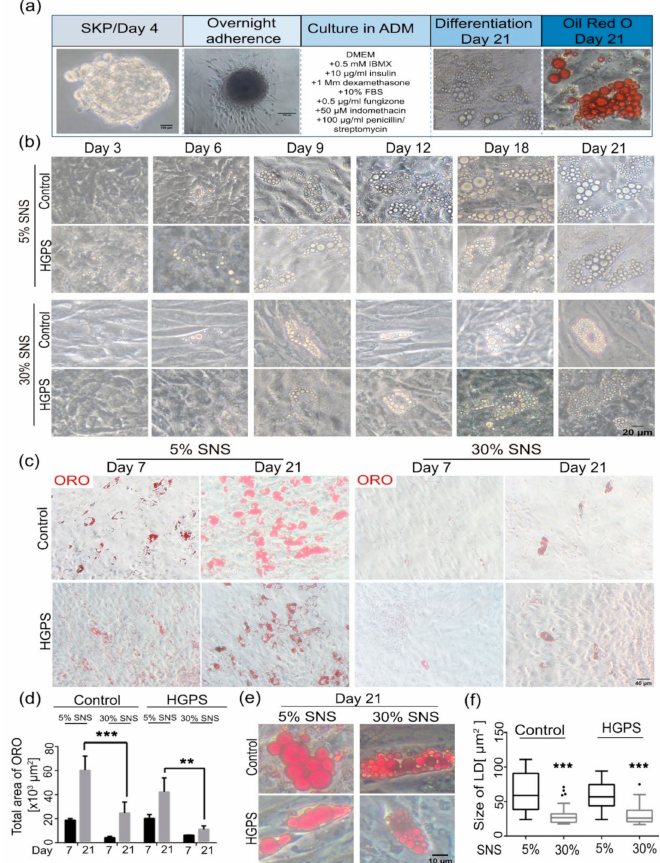
Figure 2. Differentiation of control and HGPS SKPs into adipocytes. ( a ) Panel showing the protocol of SKPs adherence and differentiation. SKPs were collected at day 4 and allowed to adhere overnight in the presence of SKP adherence media. Next, the media was replaced with ADM supplemented with insulin, IBMX, and dexamethasone. Differentiation occurred for 21 days, and the differentiated adipocytes were stained with Oil Red O (ORO) at day 21. ( b ) Bright-field imaging of the differentiation of control and HGPS SKPs with 5 and 30% SNS into adipocytes at different time points. ( c ) ORO staining for differentiated control and HGPS SKPs originating from 5- and 30%-senescence fibroblast cultures at day 7 and 21 of adipogenesis. ( d ) Quantification of total ORO-stained area using Image J. ( e , f ) Quantification of the size of lipid droplets in control and HGPS groups with 5 and 30% SNS at day 21 of differentiation. ( d ) Values are presented as mean ± SD ( n = 3). ( f ) In the Box and Whisker plot, the horizontal line crossing the box is the median, the bottom and top of the box are the lower and upper quartiles, the whiskers are the minimum and maximum values, and the dots represent the outliers, ** p < 0.01, *** p < 0.001, ( d ) two-way ANOVA with Tukey’s multiple comparisons